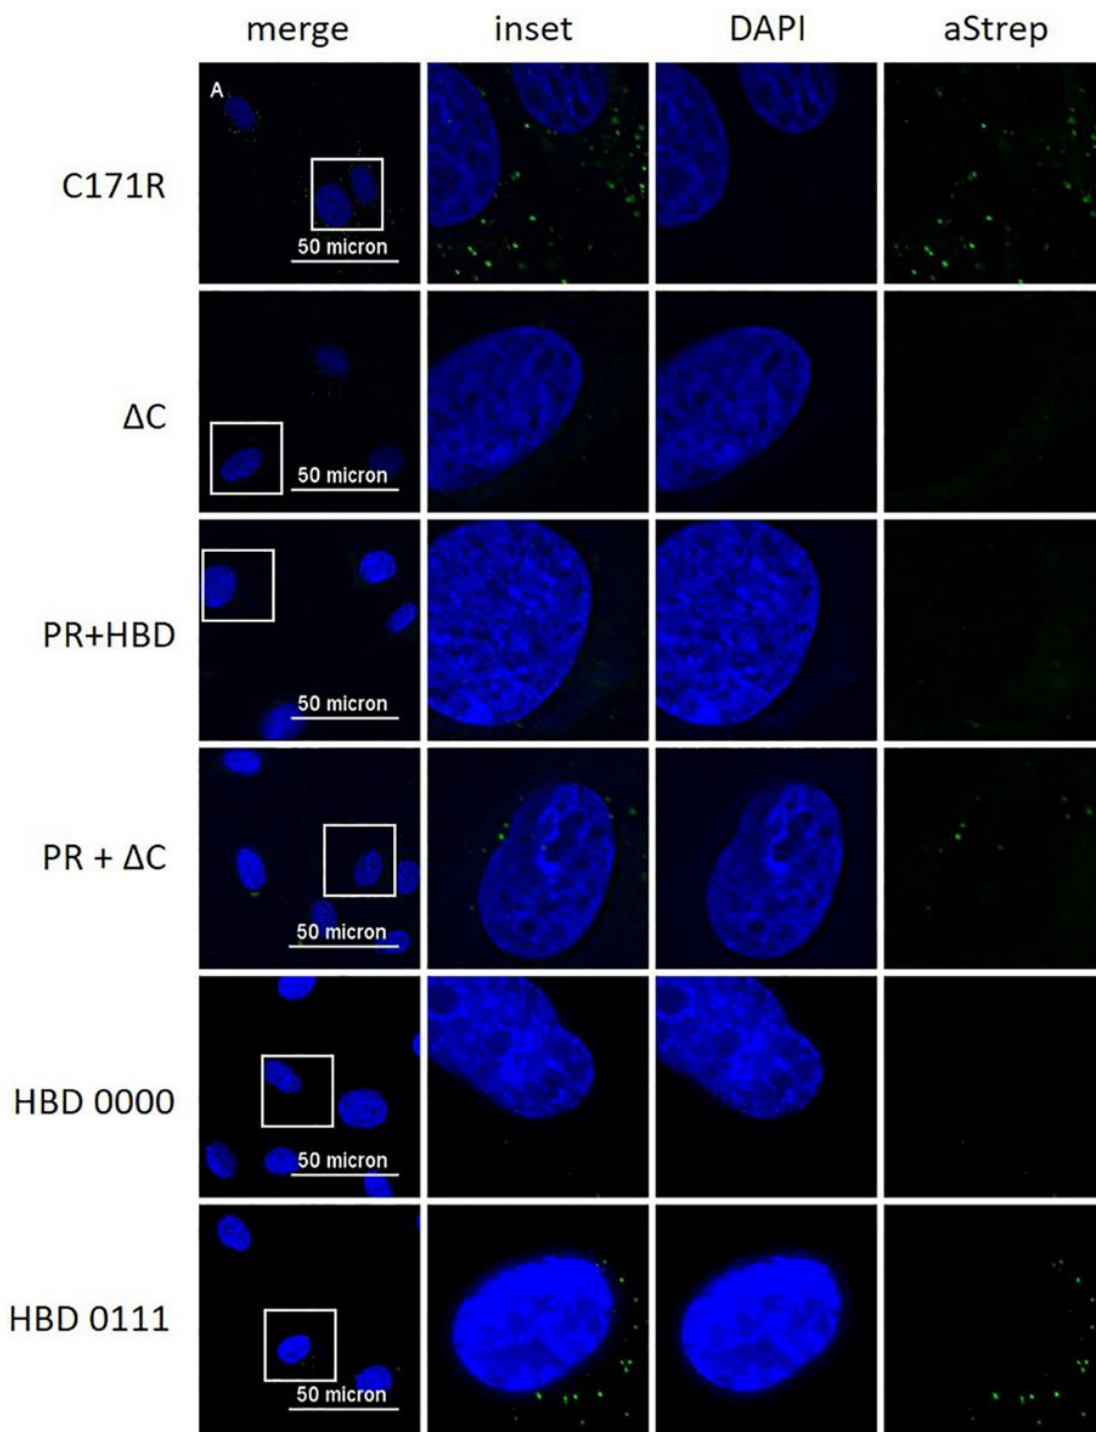
Figure 5. Immunofluorescence analysis of various mutants of E rns with a Strep-tag antibody. Various E rns mutants as indicated to the left at a concentration of 10 ng /μL were incubated on BT cells for 30 min. E rns was detected by immunofluorescence microscopy as described in the Methods Section using a primary antibody (“aStrep”) against the Strep-tag present at the C-terminus of each construct and a secondary antibody conjugated with Alexa 488 (green). Nuclei were stained with DAPI (blue) present in the mounting medium. The same image processing settings were used for mock and all constructs. For each picture, an area was selected (white square) for magnification and displayed to its right-hand side ( “ inset ” as merged image and DAPI and aStrep for the individual ones). One representative experiment out of three is shown.